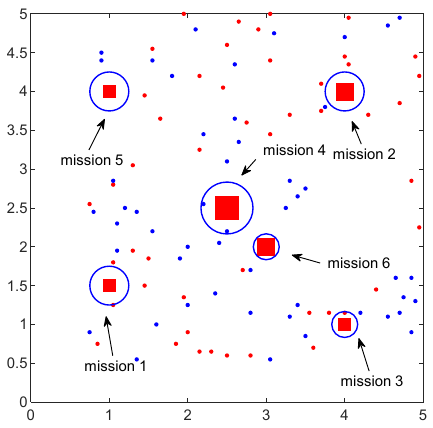
Figure 5. The combat situation of UAVs mission planning.